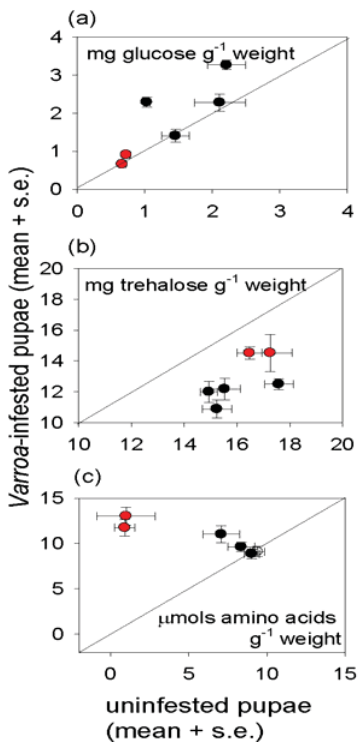
Figure 4. Free metabolites in uninfested and Varroa -infestedhoney bees (mean ± s.e, 12 replicates), with the diagonal line of equivalence. Data for colonies with Varroa above the threshold for intervention are shown in red, and colonies below the threshold in black. The statistical analysis is shown in Supplementary Table